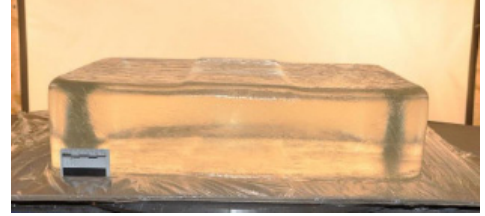
Figure 2. Perma-Gel block [15].